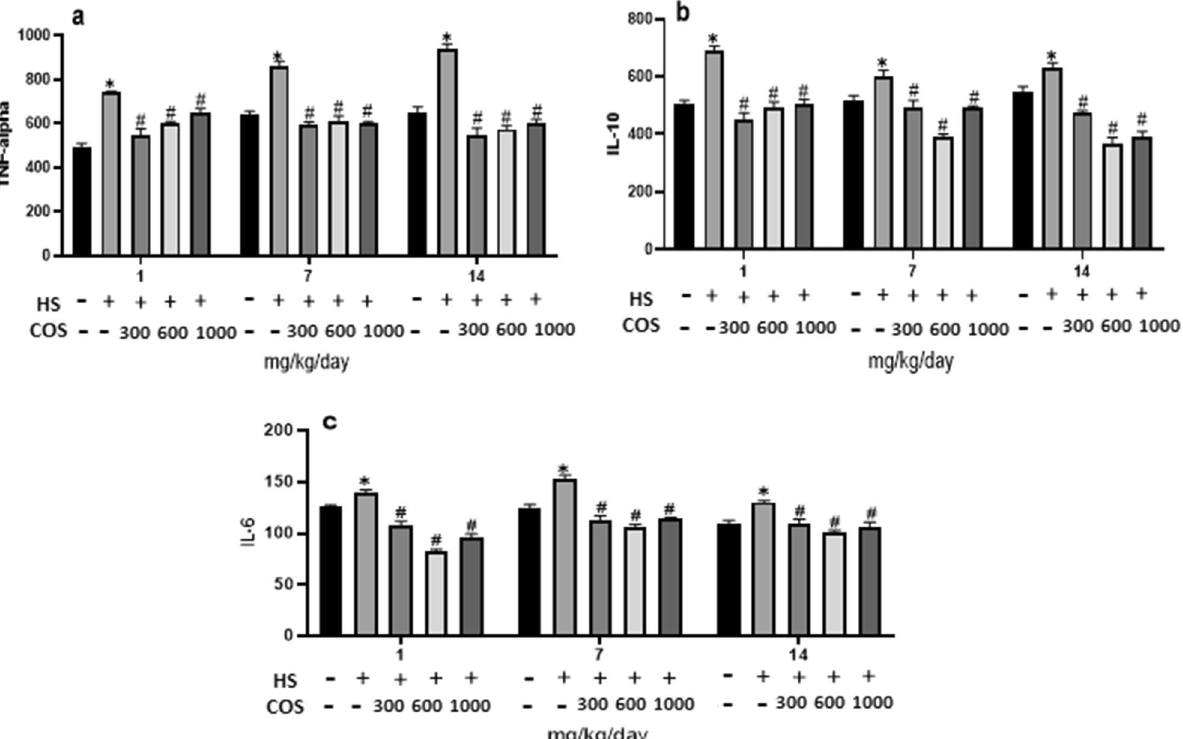
Figure 6. Effects of chitosan on the inflammatory cytokines. ( a ) TNF-alpha ( b ) IL-10 ( c ) IL-6. Control: normal mice; HS: Heat stress mice; COS-LD: mice treated with HS plus COS (300 mg/kg); COS-MD: mice treated with HS plus COS (600 mg/kg); COS-HD: mice treated with HS plus COS (1000 mg/kg). Data are expressed as mean ± standard error. *Indicates p < 0.05 compared with the blank control group, # Indicates p < 0.05 compared with the HS control